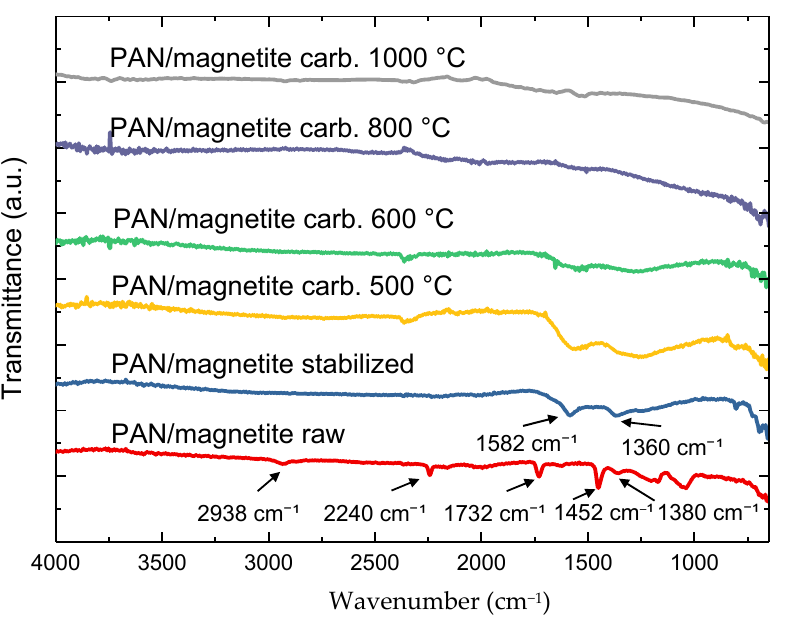
Figure 6. Fourier-transform infrared spectroscopy (FTIR) measurements of PAN/magnetite samples after electrospinning, stabilization, and carbonization at 500 °C, 600 °C, 800 °C, and 1000 °C. The lines are vertically offset for clarity.